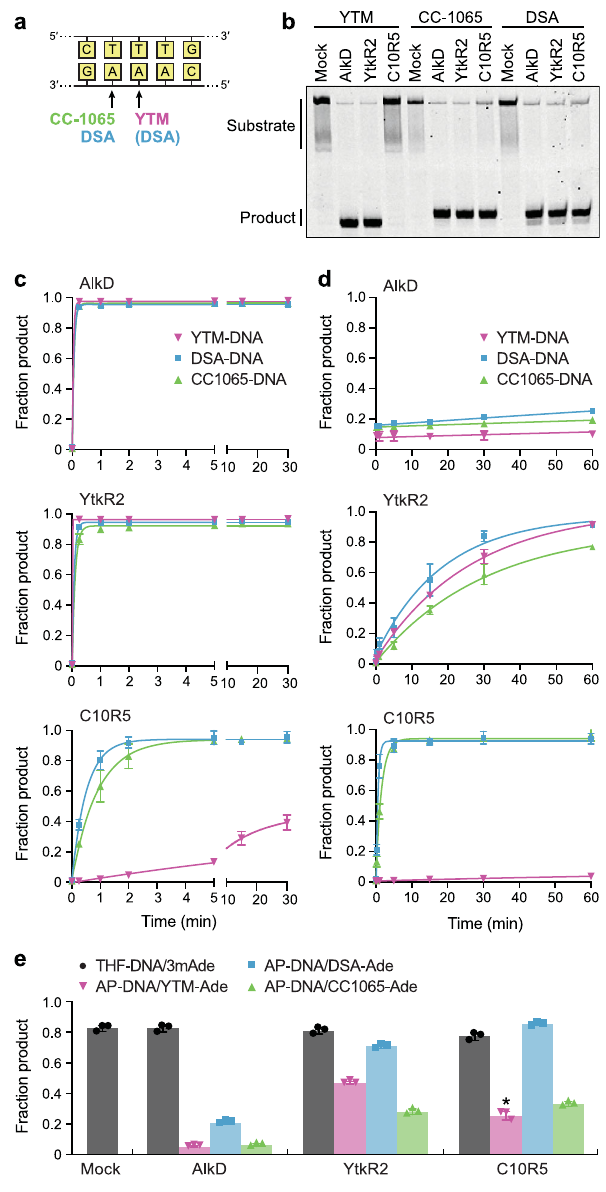
Fig. 7), indicating product af fi nity is greater for abasic DNA in the presence of the excised SCPCHD adducts. Taken together, the base excision and AP-DNA incision data suggest that YtkR2 and C10R5 evolved to possess lower product af fi nities than AlkD for abasic DNA derived from SCPCHD lesions. Moreover, this apparently reduced product af fi nity correlates with the increased cellular resistance provided by these specialized homologs (Figs. 3